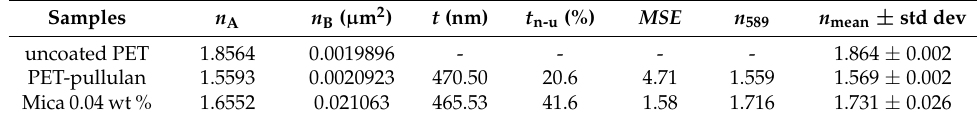
Table 4. Parameters n A , n B , t , and t n-u of the top layer obtained by fitting the ellipsometry Ψ ( λ ) and Δ ( λ ) experimental data, MSE of the fitting, and deduced refractive index of the top layer both at 589 nm ( n 589 ) and averaged in the visible range from 400 nm to 700 nm ( n mean ± std dev).